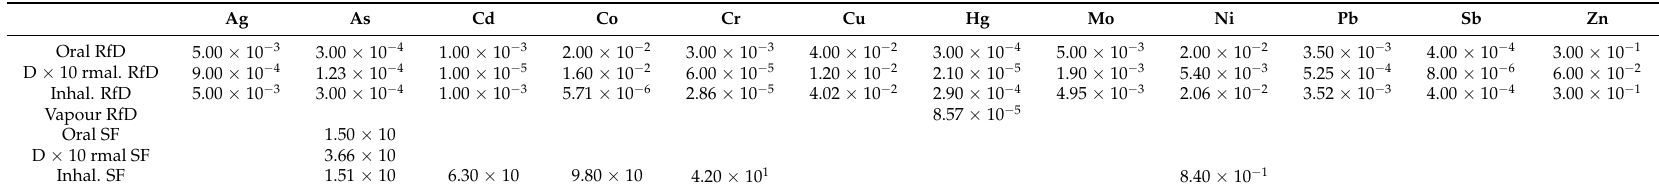
Table 2. Relative toxicity values used in this study